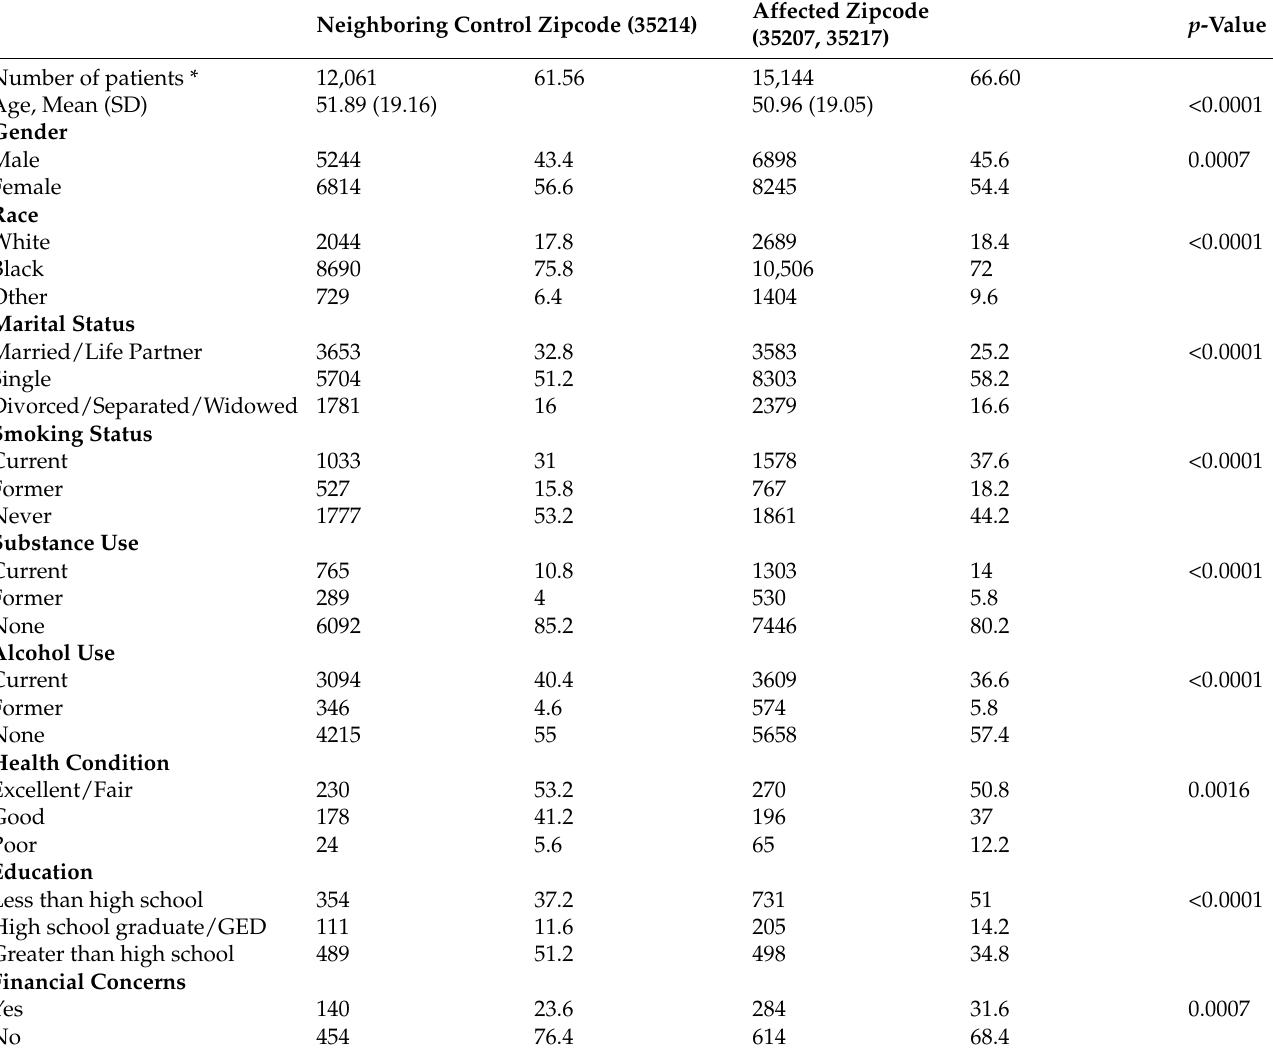
Table 1. Socio-demographics, behaviors, and health condition by neighboring (control) vs. Superfund site